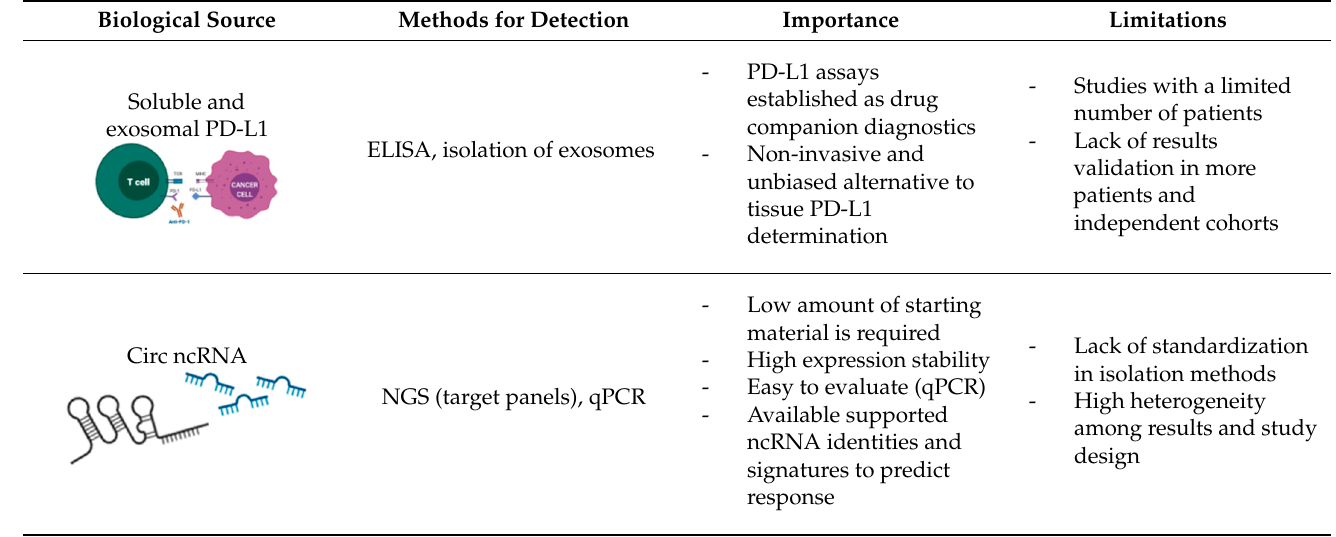
Table 5. Summary of advantages and limitations of reviewed liquid biopsy biomarkers.